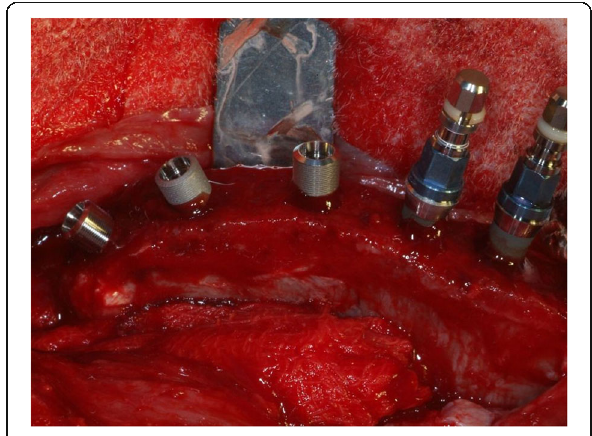
Fig. 4 Exemplificative photo of implant placement in sheep iliac crest (left side). All implant groups were inserted in the same bone